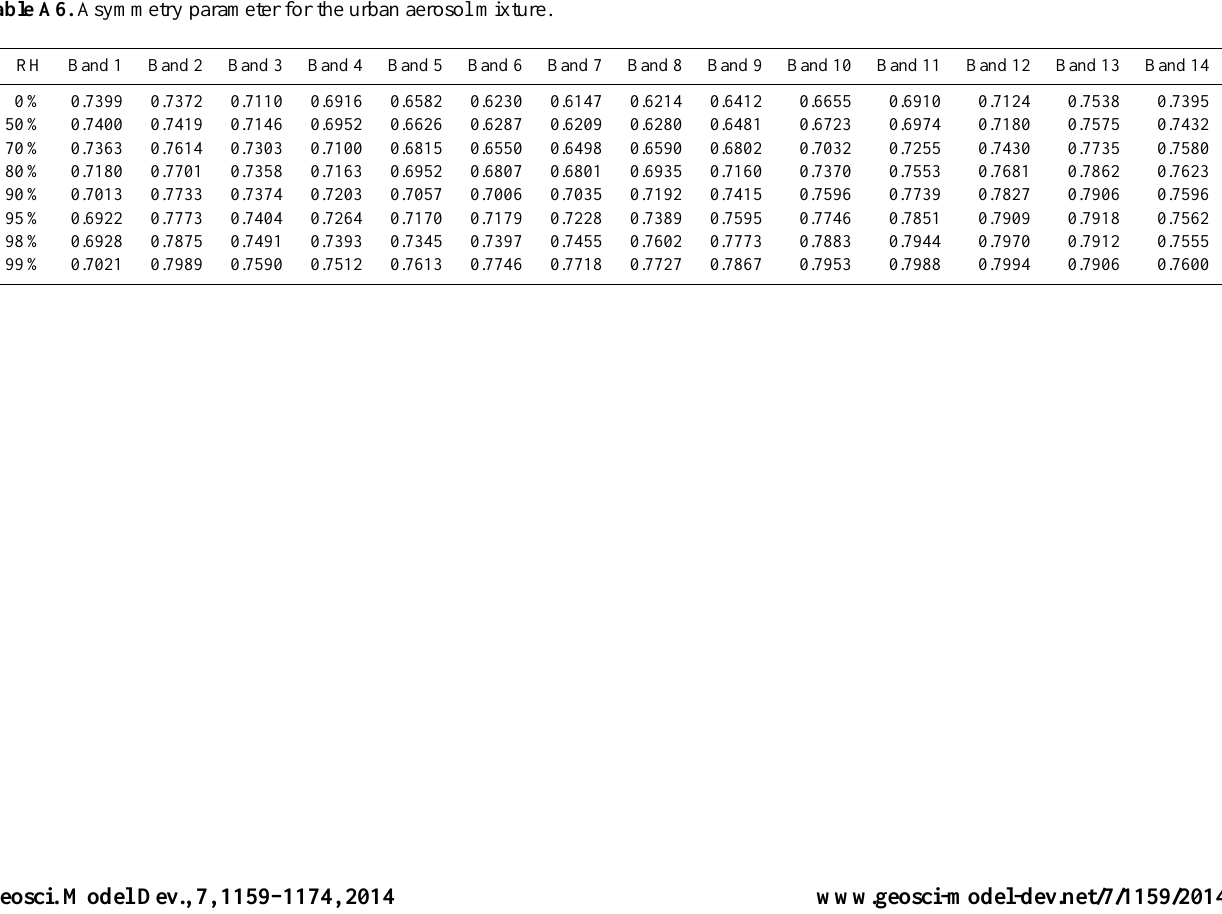
Table A6. Asymmetry parameter for the urban aerosol